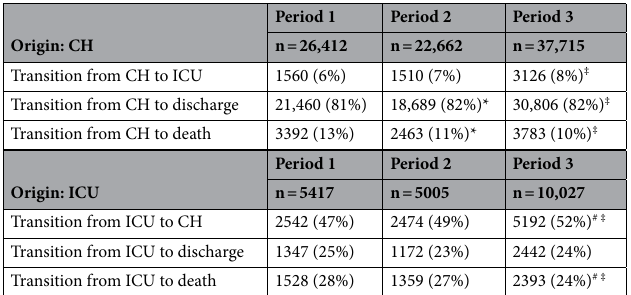
Table 2. Main results obtained from transition matrices. Data are expressed in number of hospital stays (%). CH conventional hospitalization, ICU intensive care unit. *Significant difference between period 1 and period 2. # Significant difference between period 2 and period 3. ‡ Significant difference between period 1 and period